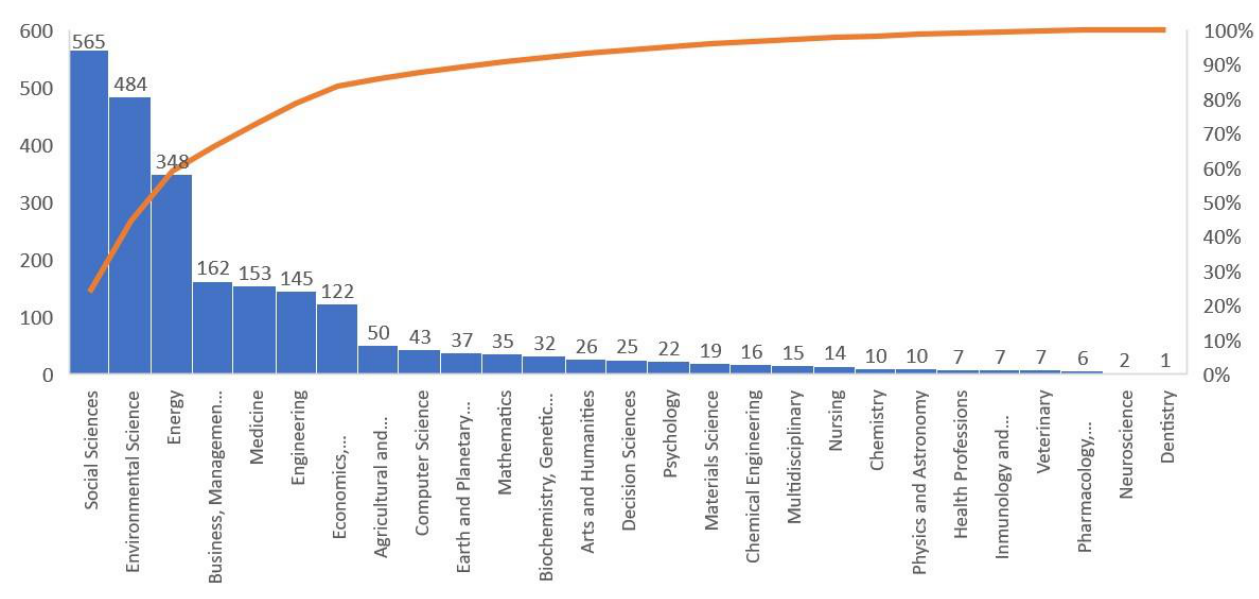
Figure 3. Distribution of articles by subject area.